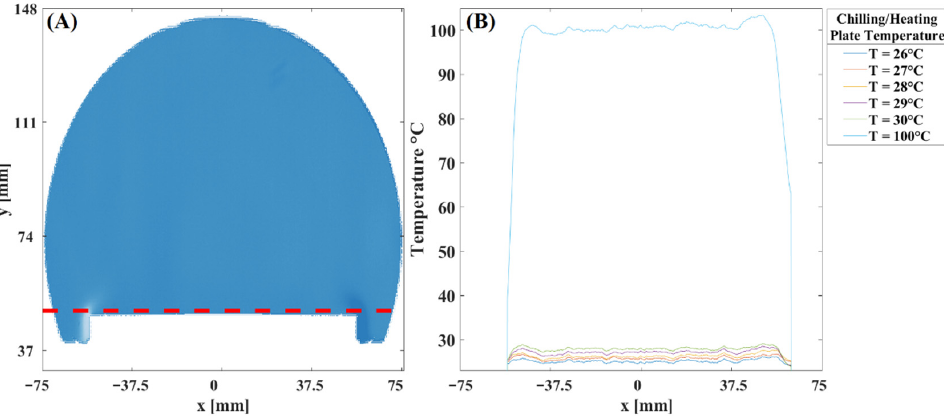
Figure 6. The temperature profile fields of the plate close to the surface. ( A ) Schlieren image at a temperature of 1.6 mm on the surface of the plate, ( B ) temperature profiles for the different temperatures of the rectangular plate.